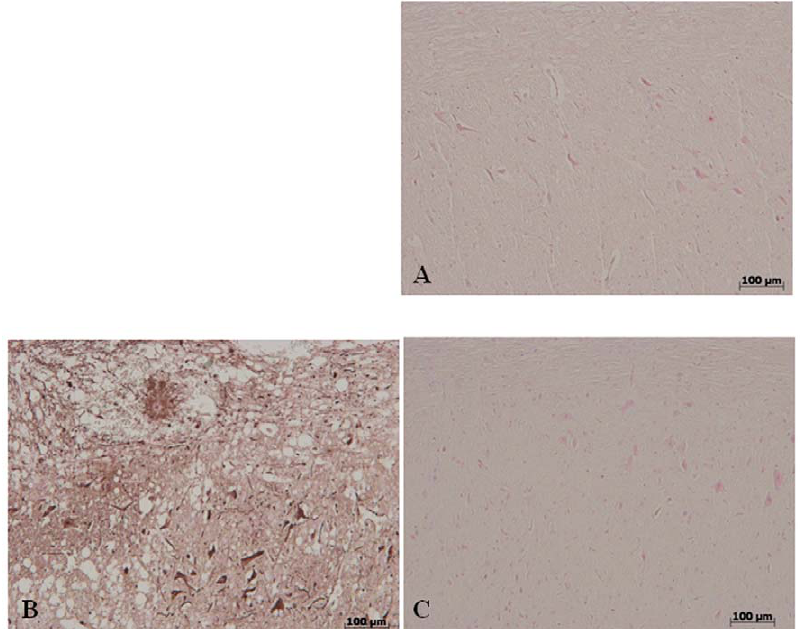
Figure 2. Effect of olprinone treatment on astrogliosis in the spinal cord tissue 24 h after injury. No positive staining for GFAP were observed in the spinal cord tissues collected from sham-operated mice ( a ). A significant presence of GFAP positive cells was found in the spinal cord, from SCI operated mice at the perilesional area 24 h after injury ( b ). Notably, a significant reduction of GFAP positive cells was observed in the tissue collected from olprinone-treated mice ( c ). This figure is representative of at least 3 experiments performed on different experimental days. spinal cord tissue were also significantly increased at 24 h after SCI compared to the sham-operated mice (Figure 6B; 3.66 6 0.2 vs. significantly reduced the levels of NF- k B p65 as shown in Figure 6B (1.49 6 0.41 vs. 3.67 6 0.2, p , 0.01 vs. SCI; n=5). Olprinone modulates the induction of phospho-ERK and phospho-P38 after SCI 6.78 6 0.7 vs. 1.33 6 0.2, p , 0.01 vs. Sham; n= 5). The treatment of mice with olprinone significantly reduced the level of pERK1/2 (Figure 7A; 3.21 6 3.2 vs. 6.78 6 0.7, p , 0.01 vs. SCI; n =5). In addition, at 24 h after SCI, the activation of phospho-P38 in spinal cord homogenates was investigated by Western blot. A significant increase in phospho-P38 (Figure 7B; 5.97 6 0.6 vs. 0.36 6 0.1, p , 0.01 vs. Sham; n= 5) levels were observed in the spinal cord from mice subjected to SCI. On the contrary, olprinone treatment prevented the SCI-induced (Figure 7B; 2.40 6 0.3 vs 5.97 6 0.6, p , 0.01 vs. SCI; n= 5) expression of these kinases.